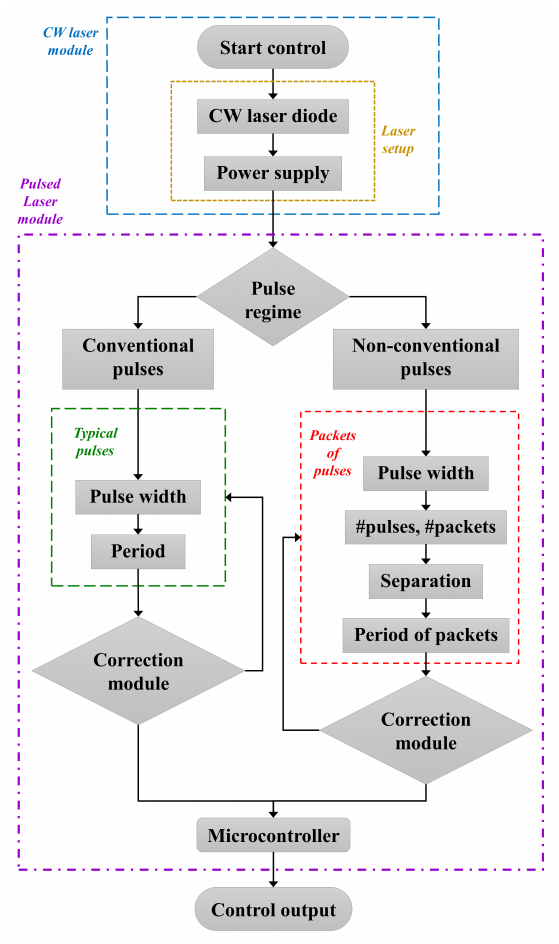
Figure 3. Conceptual flowchart of the proposal to obtain synchronous or asynchronous pulses from a CW